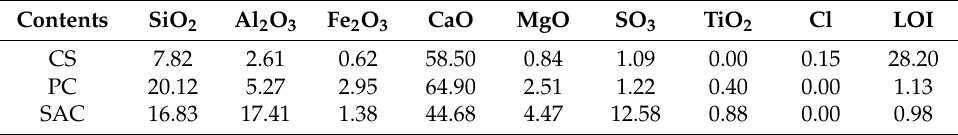
Table 1. Chemical composition of raw materials used in this research using XRF (wt%). XRF: X-ray fluorescence.